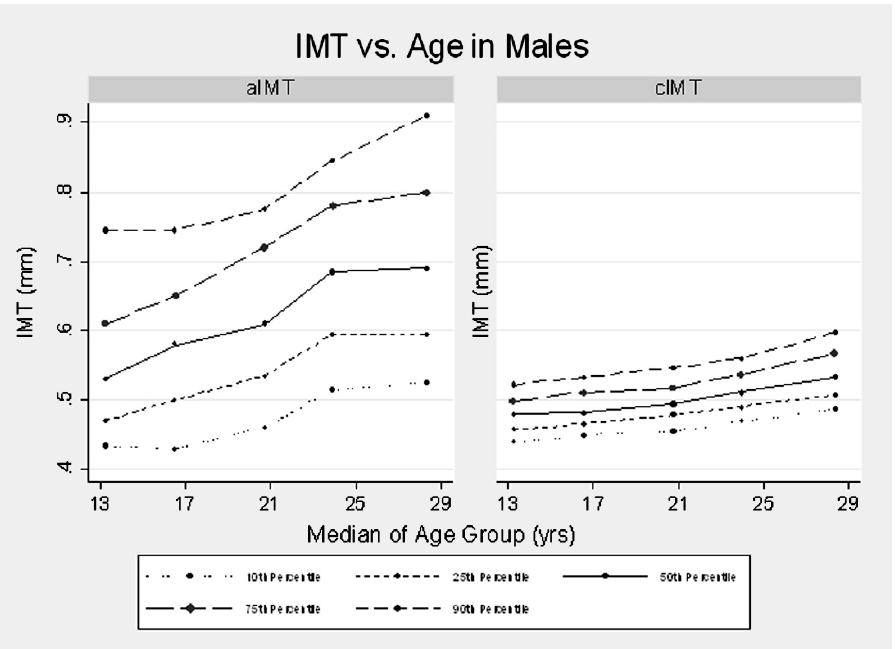
Figure 4. Percentiles of abdominal aortic intima-media thickness (IMT) and carotid IMT according to age in males. Female trends were similar but slightly lower (0.03 mm less for abdominal aortic IMT and 0.02 less for carotid IMT). The mean increase in abdominal aortic IMT with age was 0.10 mm/decade as compared to 0.04 mm/decade for carotid IMT [86] . Reproduced with permission from Davis,